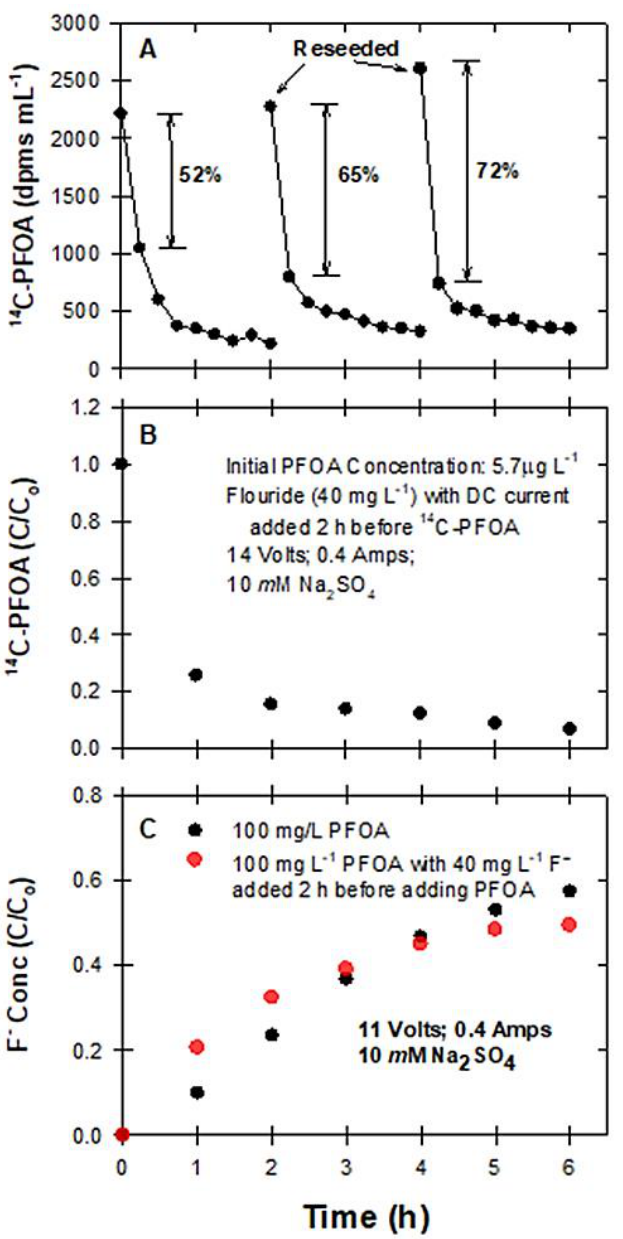
Figure 5. ( A ) Temporal changes in 14 C-PFOA following reseeding; ( B ) effect of adding fluoride (40 mg L −1 ) and treating with BDD electrodes for 2h before adding 14 C-PFOA; ( C ) fluoride generation from PFOA, with and without preconditioning of BDD electrodes with fluoride (40 mg L −1 ).